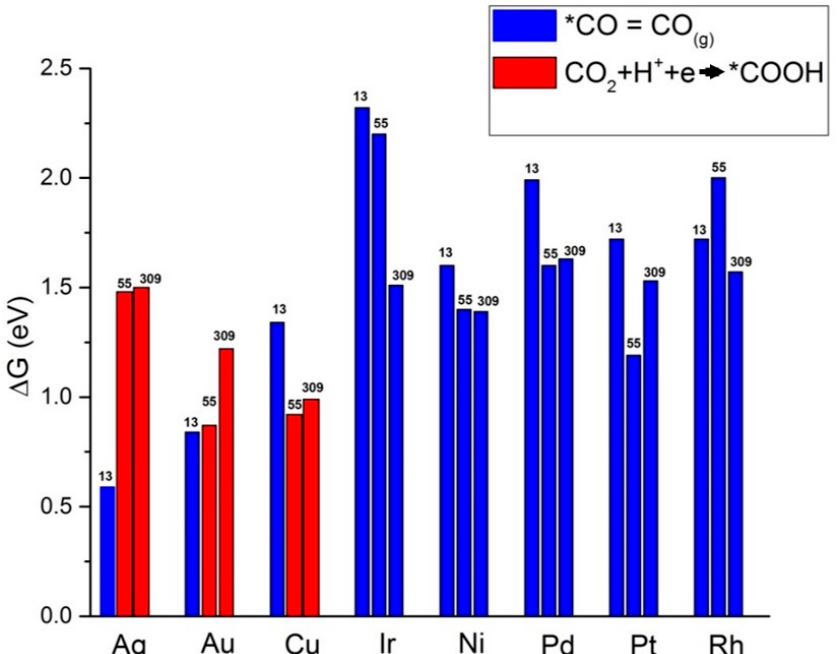
Figure 5. Calculated free energy barrier for the most difficult step in the reduction pathway for each metal. The blue and red bars correspond to *CO desorption and *COOH formation, respectively. For each metal, the left, center and right bars represent 13, 55 and 309 atom clusters. Reprinted with permission from Ref. [37]. Copyright (2017) Materials Research Society.